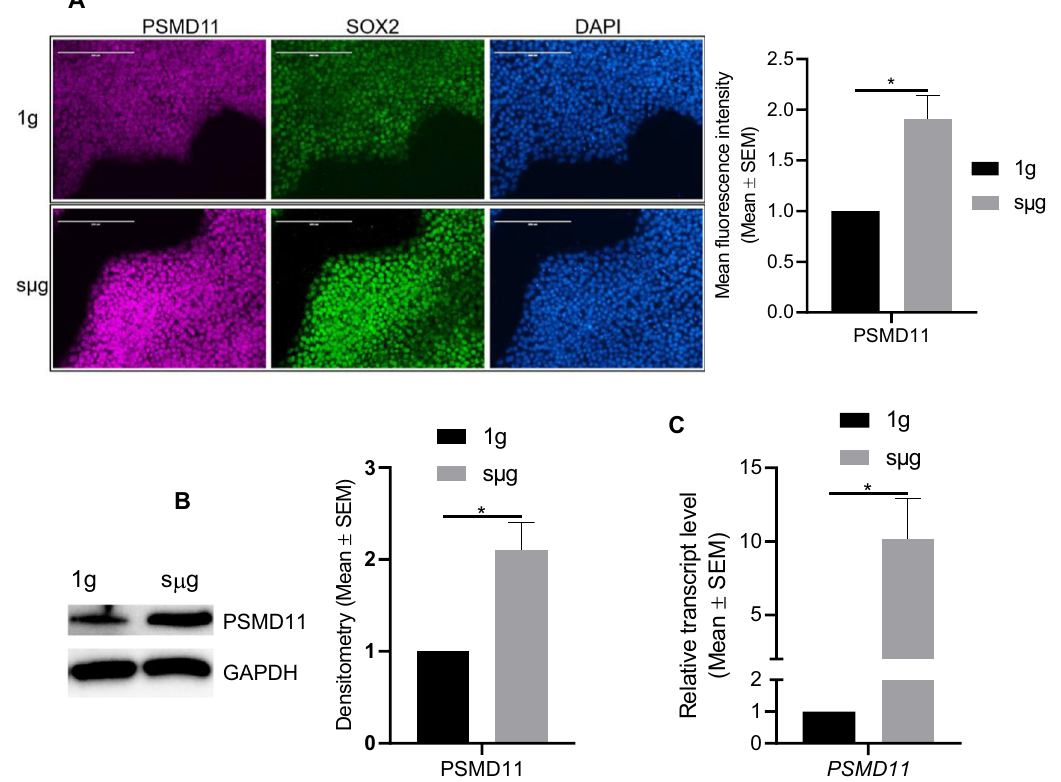
Fig. 6 Simulated microgravity (sµg) enhances PSMD11 expression in hPSCs. A Representative immuno fl uorescent micrographs of hPSCs cultured in s μ g and 1g conditions and stained for PSMD11 and SOX2. DAPI was used to stain the nuclei of all cells. Scale bars, 200 µm. Graphs showing the mean fl uorescence intensity analysis from micrographs. B Representative Immunoblots and densitometry analysis of PSMD11 from protein lysates of cells cultured at s μ g and 1g conditions. GAPDH was used as a loading control. Graphs on the right show the densitometry analysis of the immunoblots. C RT-qPCR analysis indicating the relative mRNA levels of PSMD11 present in cells cultured at s μ g compared to 1g condition. * p < 0.05 ( n = 3; unpaired t test). Error bars in graphs represent the SEM of the